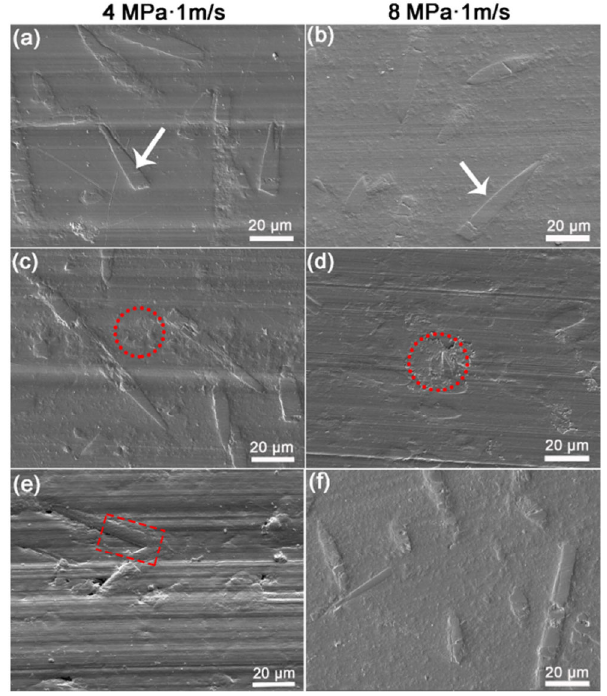
Fig. 12 Morphology of the worn surfaces of (a, b) PI/SCF, (c, d) PI/SCF/SiO 2 , and (e, f) PI/SCF/BN when sliding against Al 2 O 3 at 4 and 8